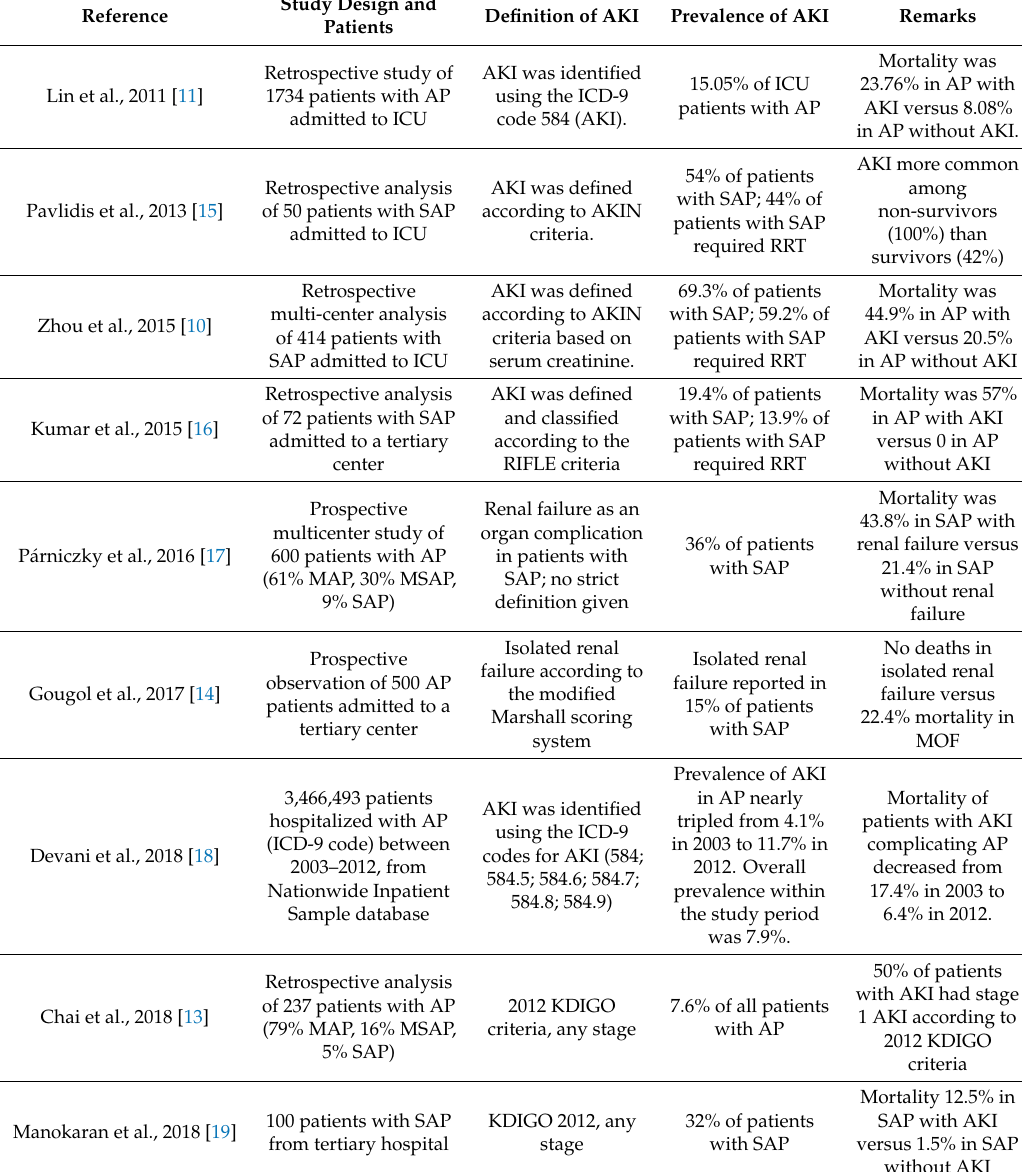
Table 1. The data on the prevalence of acute kidney injury (AKI) in patients with acute pancreatitis